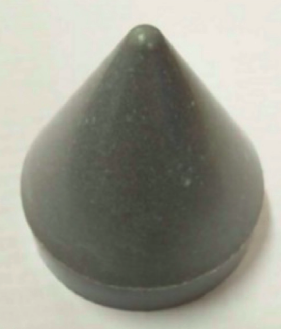
Figure 10: Al/PTFE/W composite